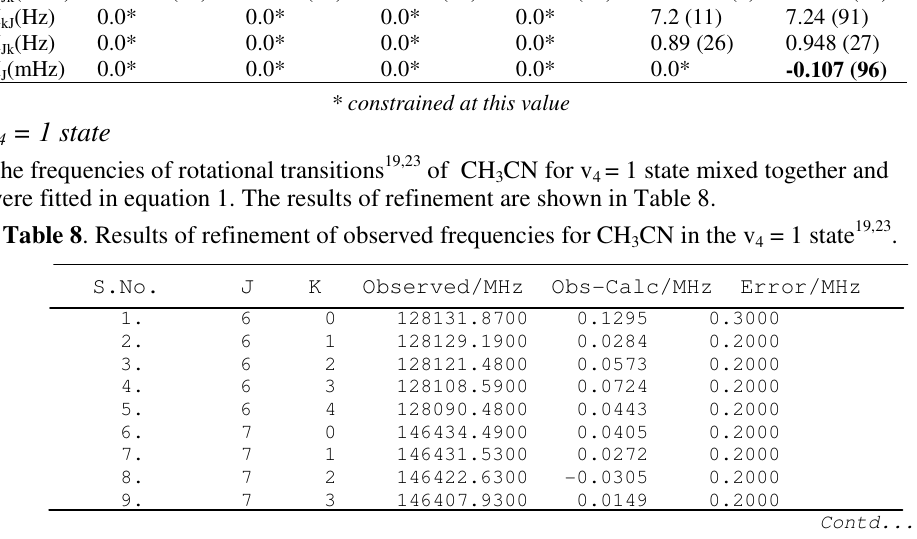
Table 8 . Results of refinement of observed frequencies for CH